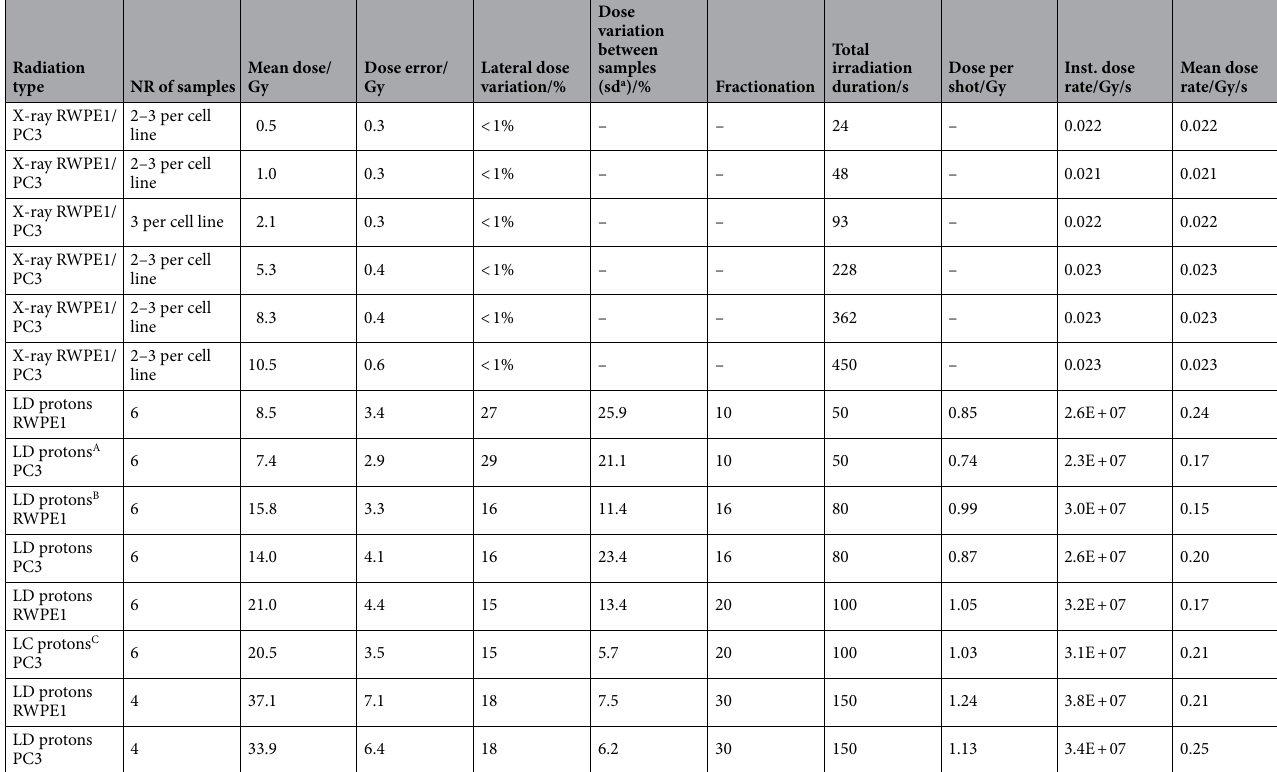
Table 1. Comparison of dose distribution in each dose group for laser-driven protons and reference X-rays (grey areas are LD proton results and white areas are reference X-ray results). A, B, C: examples of histograms and lateral dose distributions are displayed in Fig. 3. a Standard